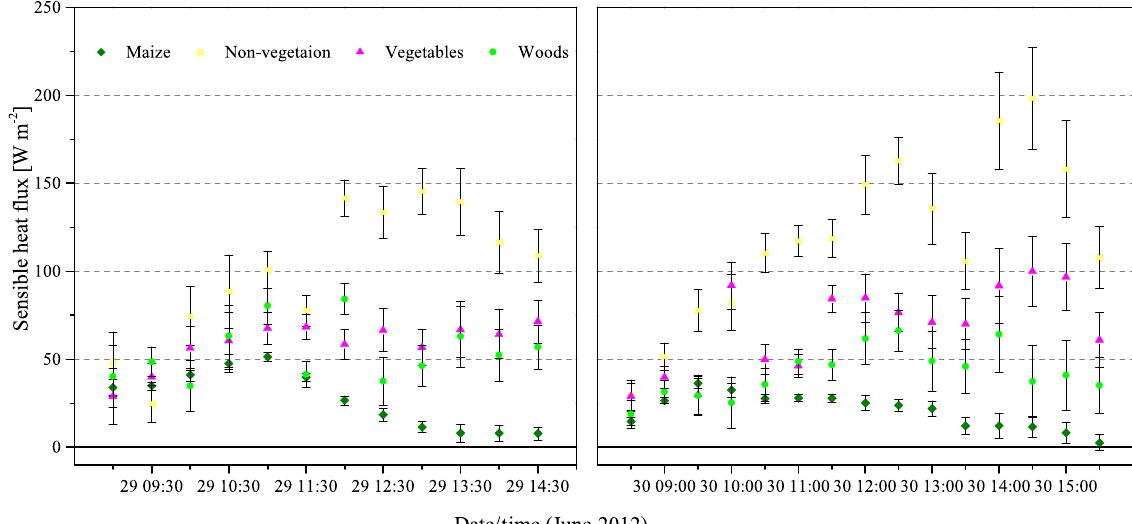
Figure 6. The diurnal cycle of the sensible heat flux for each land-cover class for 29–30 June 2012; the error bars are standard errors of sensible heat flux estimated in the regression.